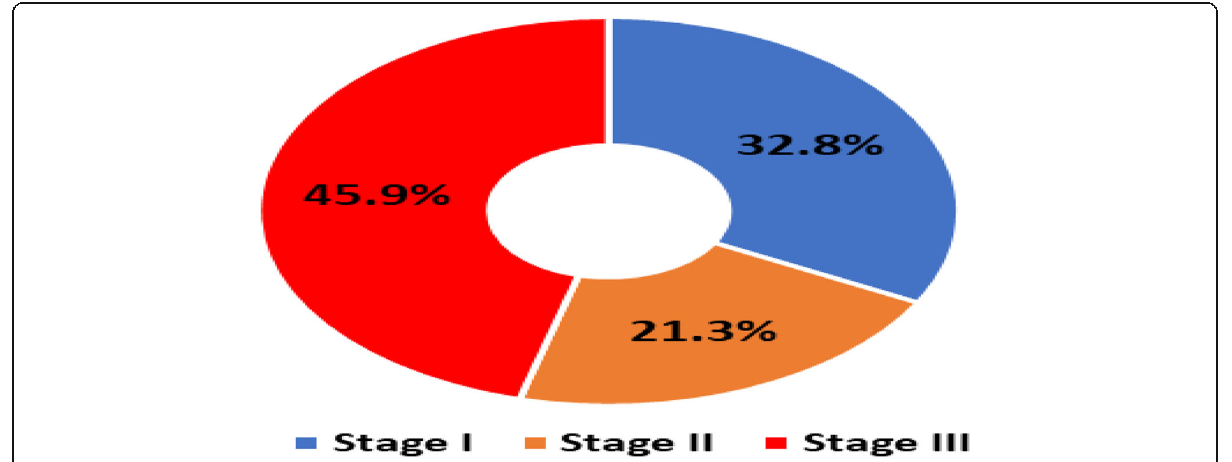
Fig. 2 Severity of AKI among the studied COVID-19 patients cohort